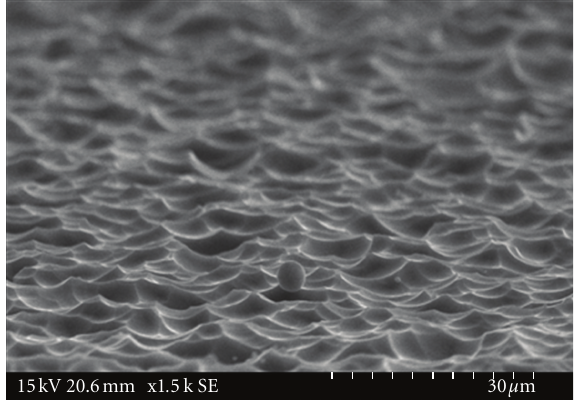
Figure 1: A scanning electron microscope (SEM) image of an acidic-textured multicrystalline silicon wafer surface showing the formation of randomly arranged etching pits on the surface. The surface was textured for 2 mins at 10 ◦ C in a solution comprising an HF:HNO 3 :H 2 O ratio of 15 :50:35.